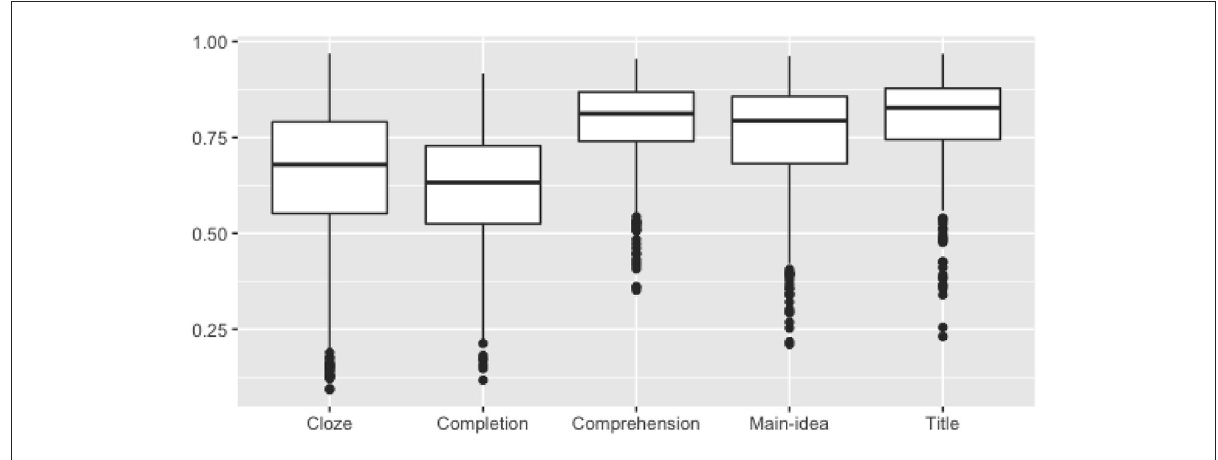
FIGURE2 Mean score (easiness)